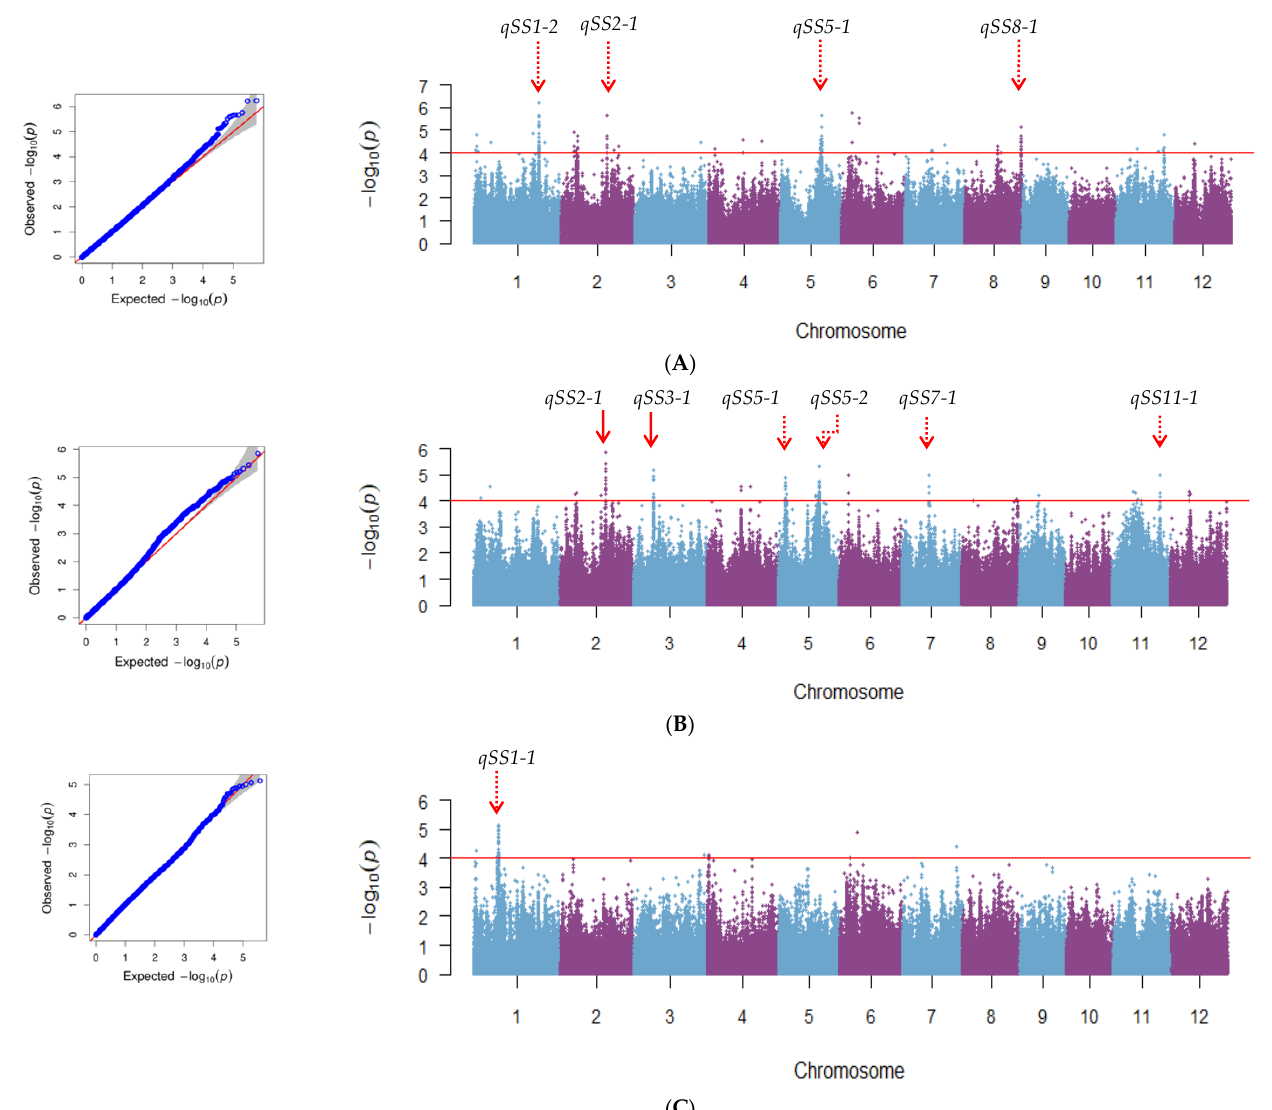
Figure 3. Quantile-quantile (Q-Q) and Manhattan plots of GWAS for rice seed storability in the whole population ( A ), indica subspecies ( B ), and japonica subspecies ( C ), respectively.